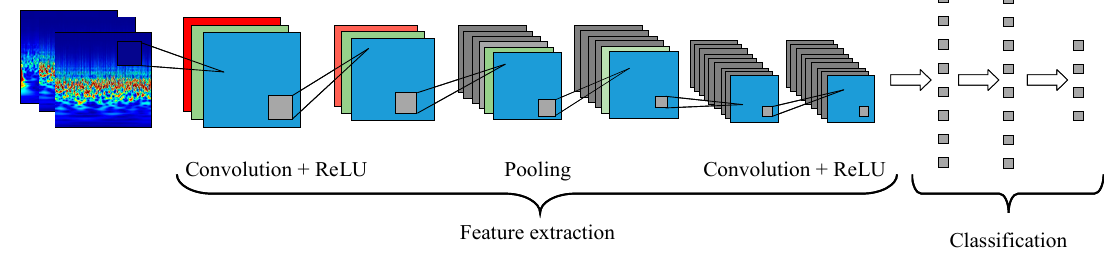
Figure 7. Deep learning convolutional neural network architecture.